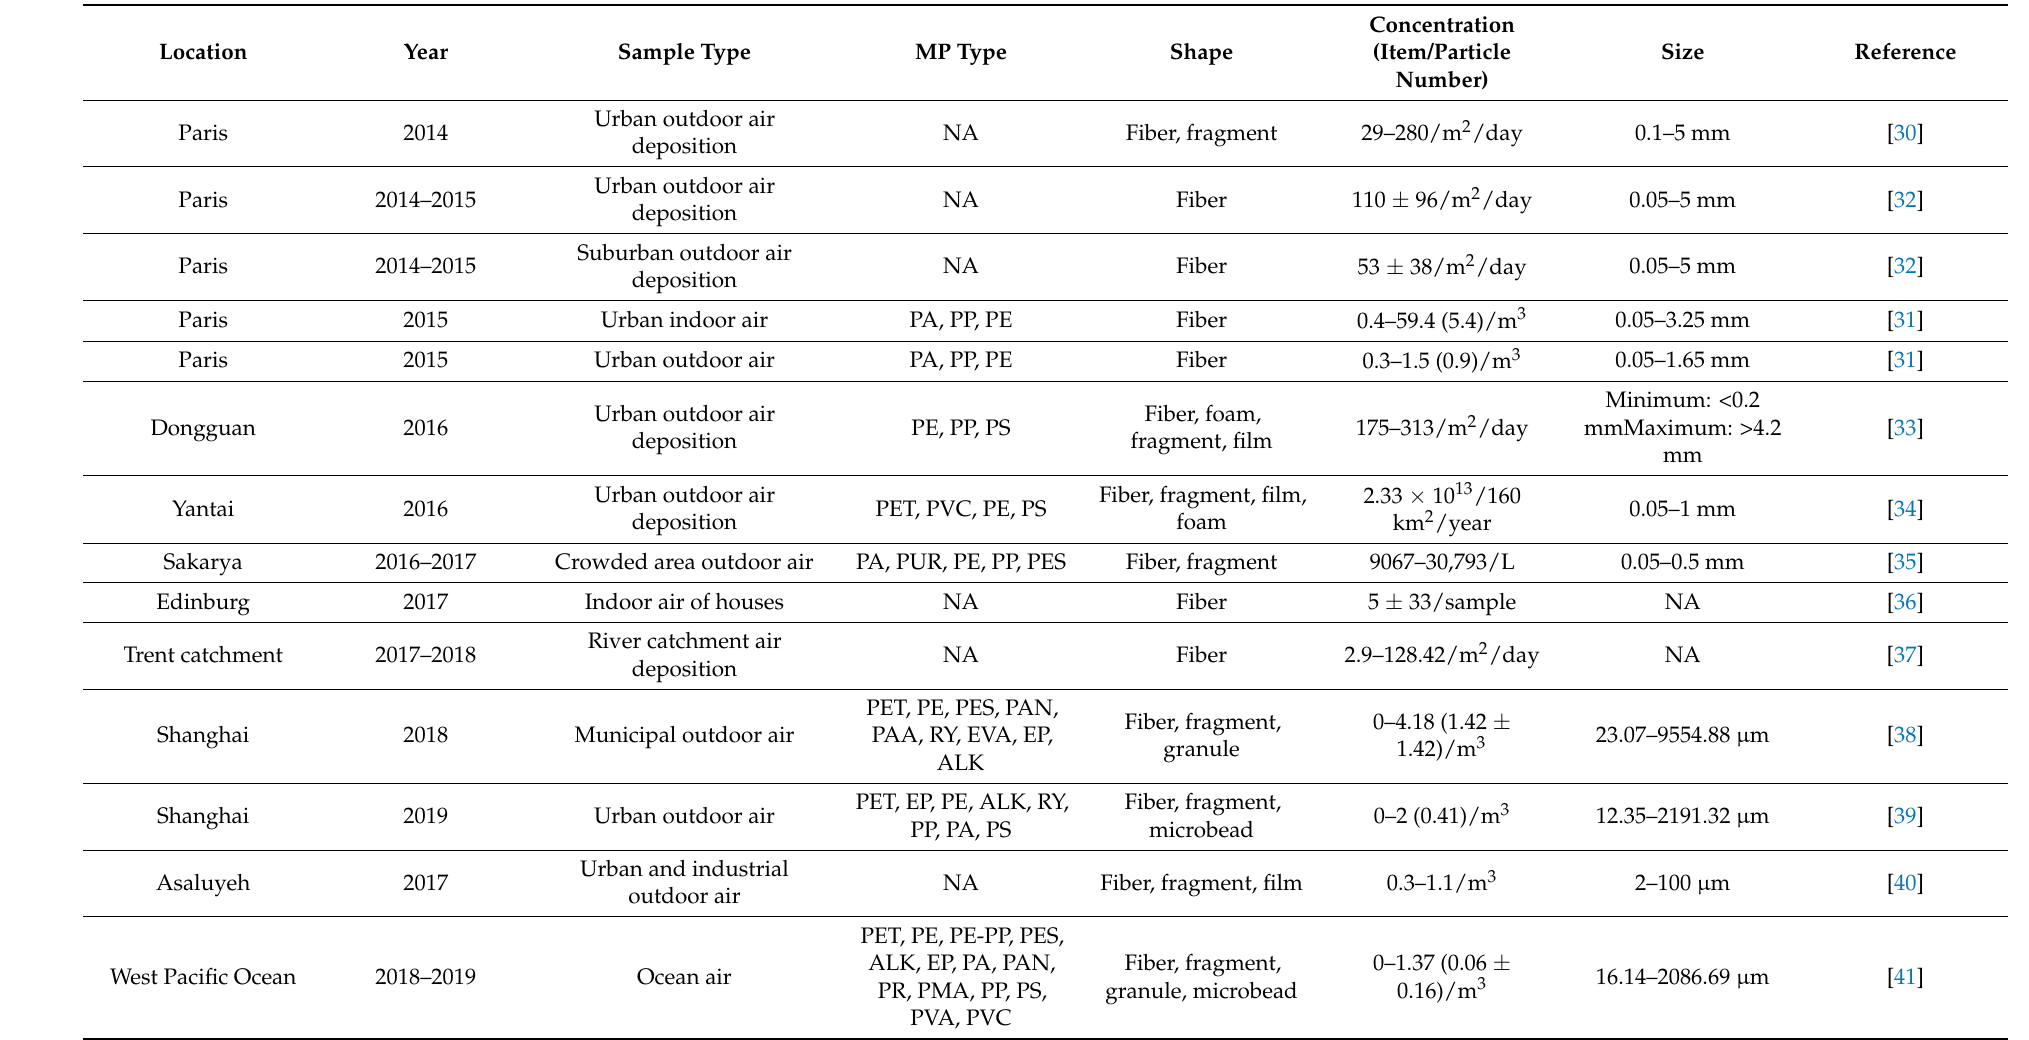
Table 1. Distribution and abundance of plastics in the